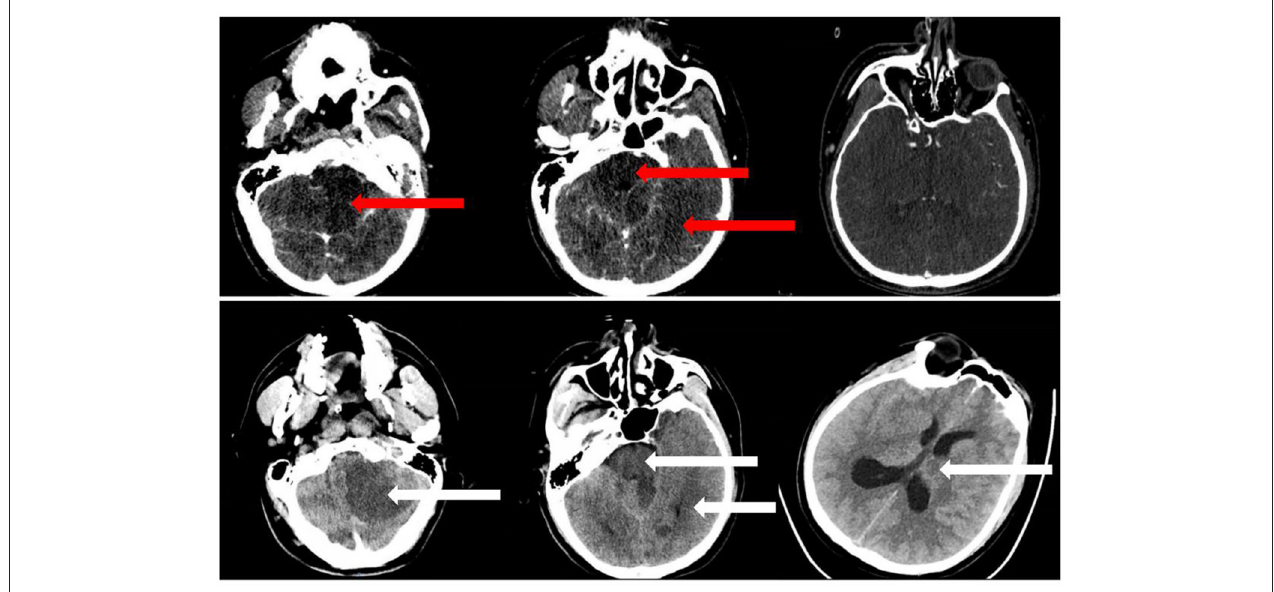
FIGURE 2 | Example of a patient with BAO in our study. We rated CT angiography (CTA) source images (CTA-SI) (upper row) posterior circulation Acute Stroke Prognosis Early CT Score (pc-ASPECTS) score 6 (hypoattenuation left PCA territory, left cerebellum, midbrain) and follow-up non-contrast CT (NCCT) (lower row) pc-ASPECTS score 5 (additional ischemic change left